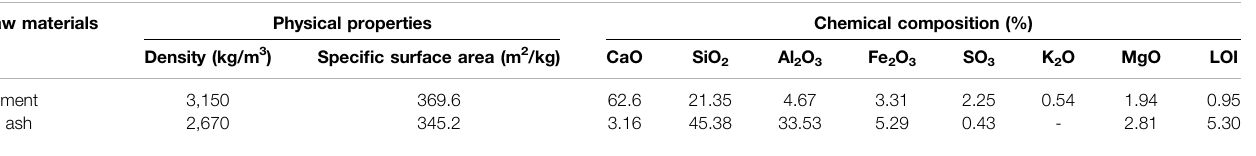
TABLE 1 | Chemical composition of cement